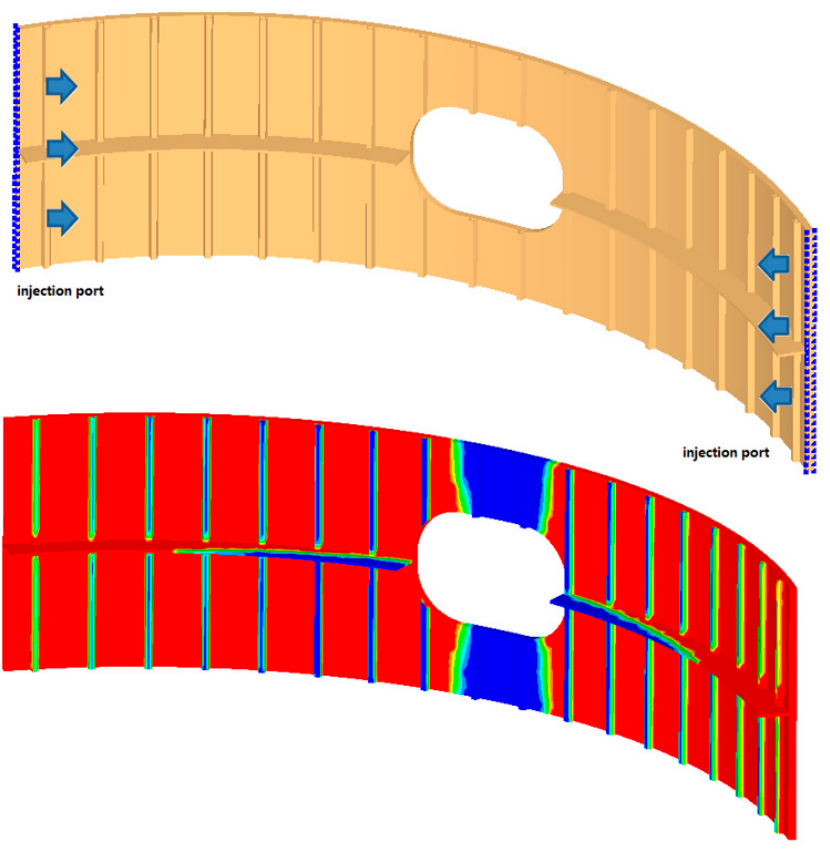
Figure 18. Injection case C for the fuselage section. J. Compos. Sci. 2020 , 4 , 10